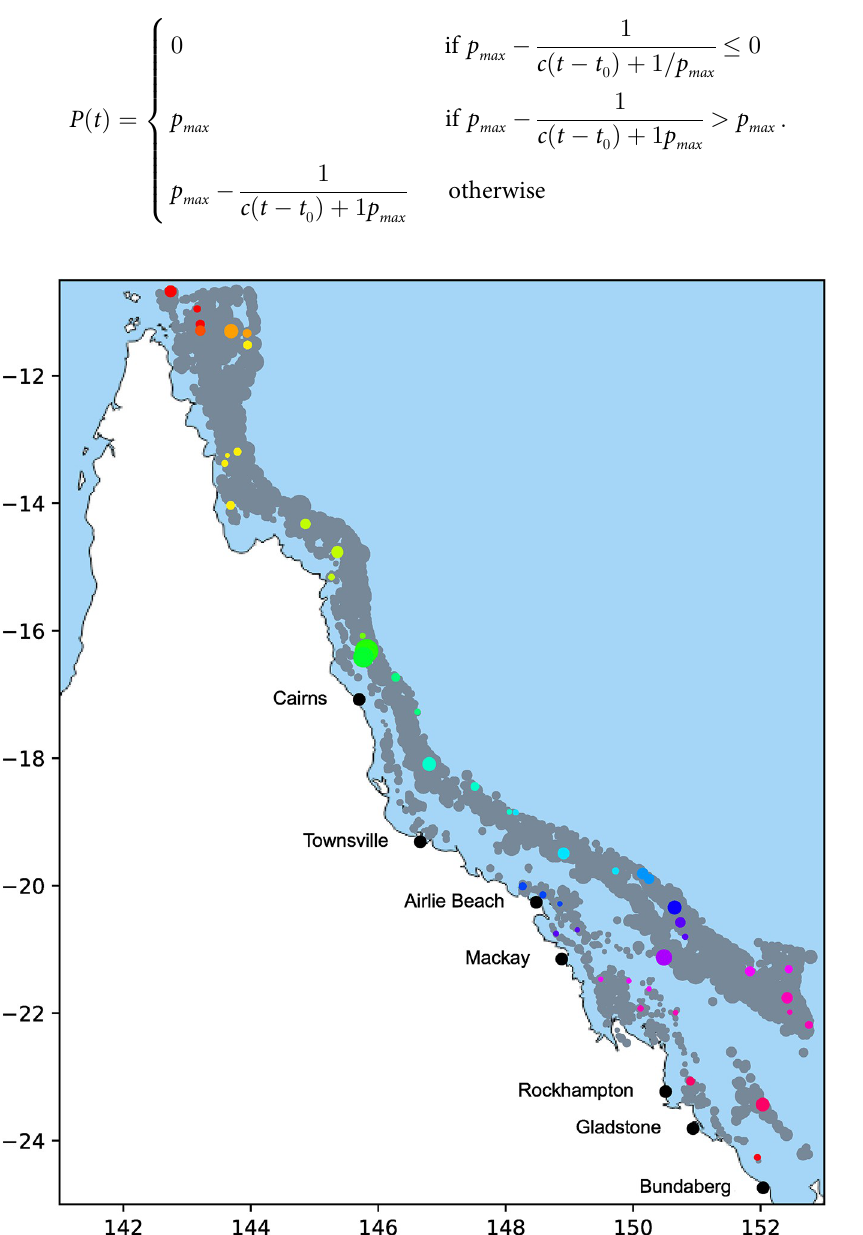
Fig 1. Reefs in AIMS dataset dispersed along the coast of Queensland. Total set of 2816 reefs are size-scaled by area. A subset of the 50 randomly chosen reefs used for the case study are coloured by cluster, with the remaining reefs coloured grey. Port locations are coloured black. Reprinted from [36] under a CC BY license, with permission from d- maps.com, original copyright 2021.